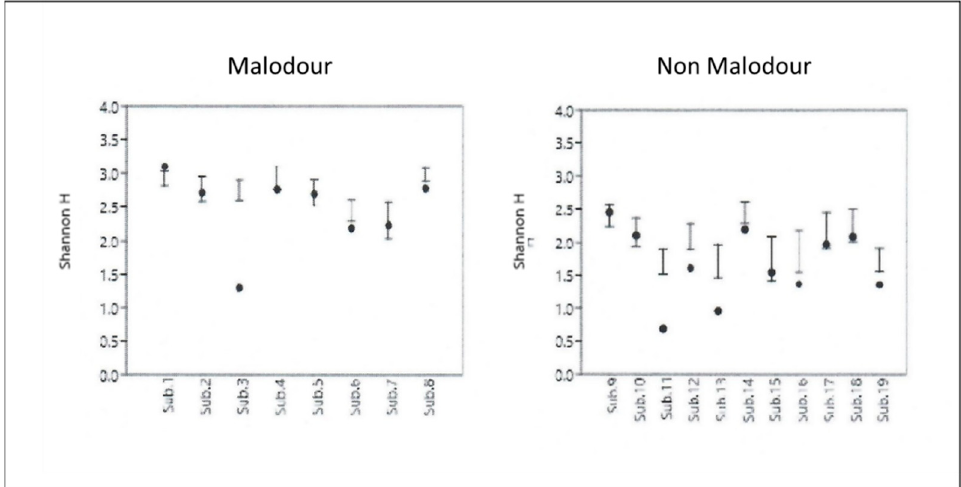
Figure 4. Diversity analysis (Shannon diversity index) conducted on the microbial populations sampled from the malodor and non-malodor groups.